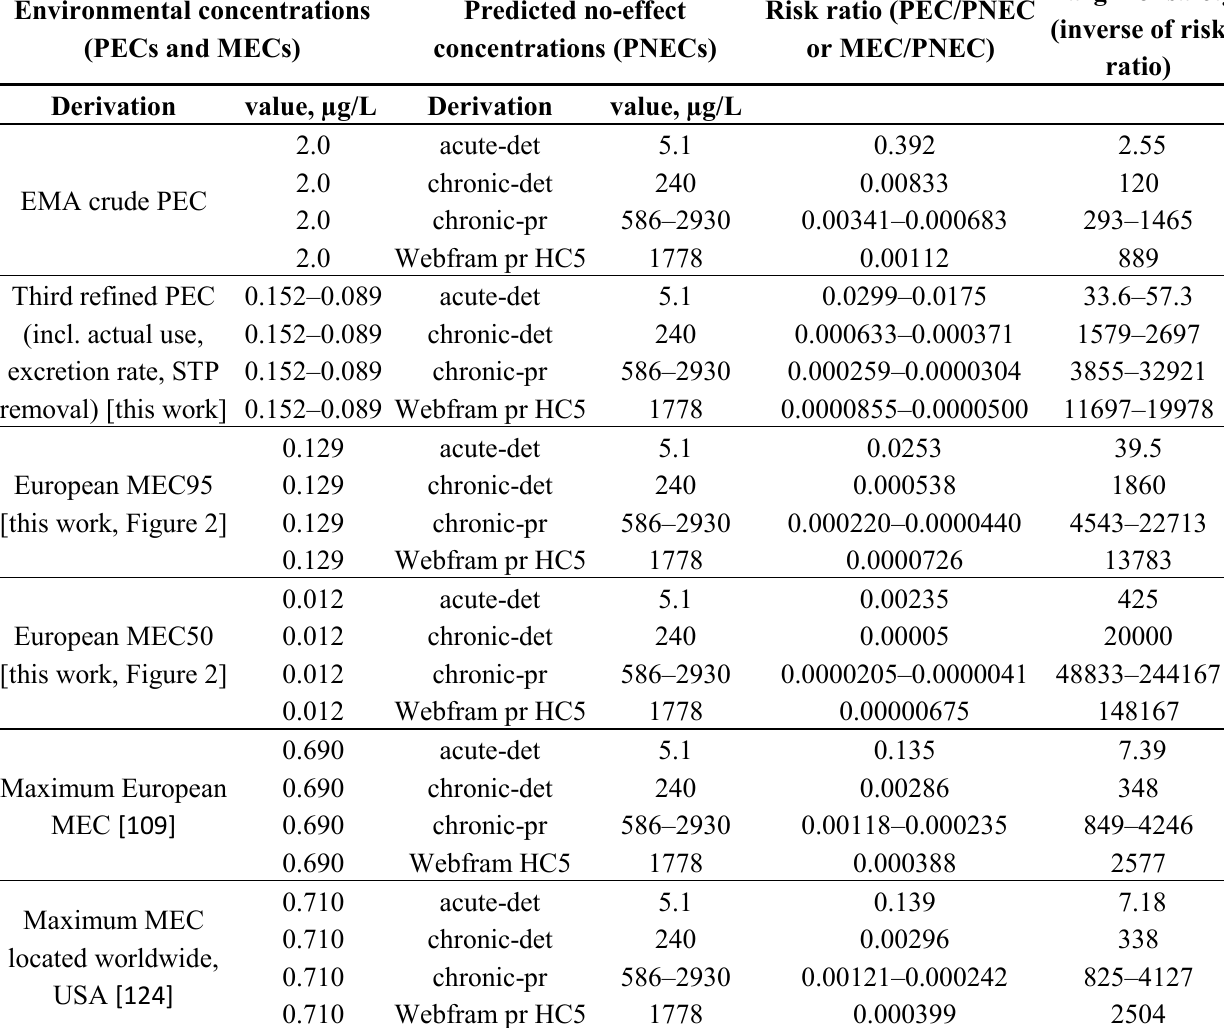
Table 2. TMP risk assessment for European surface waters: PECs, MECs, PNECs and PEC/PNEC and MEC/PNEC risk characterization ratios respectively margins of